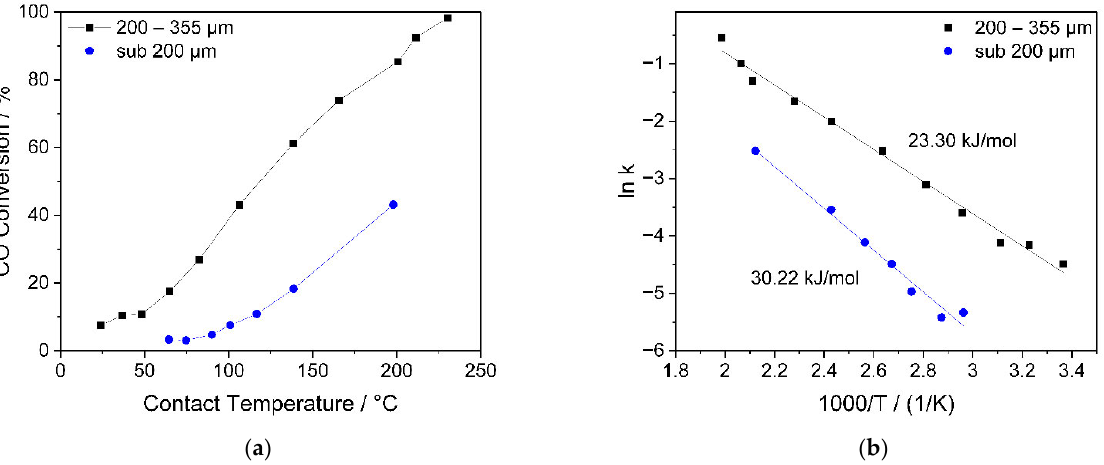
Figure 7. ( a ) Temperature-dependent catalytic CO conversion over an LSC-82 catalyst as a function of different particle size distributions of the catalyst material. ( b ) Arrhenius representation of the same data.